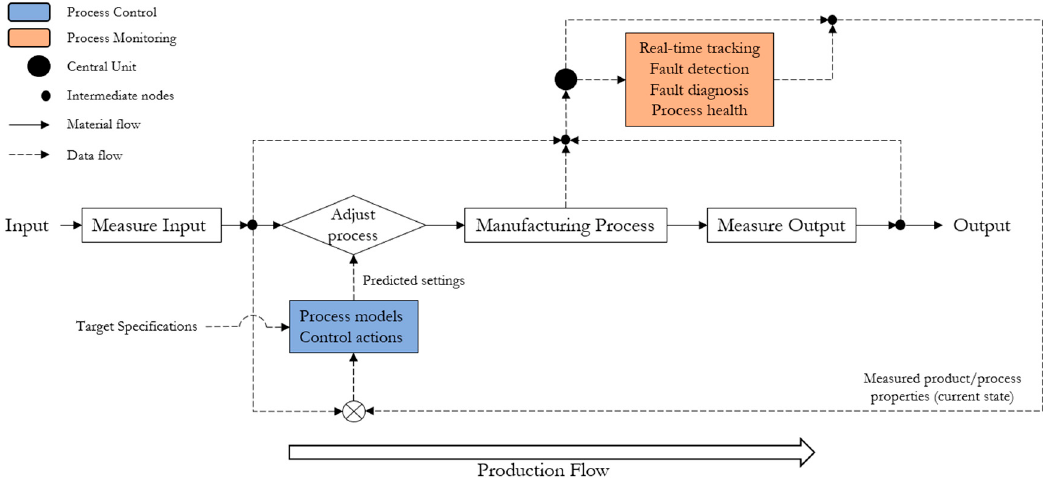
Figure 1. Schematic of the proposed framework.